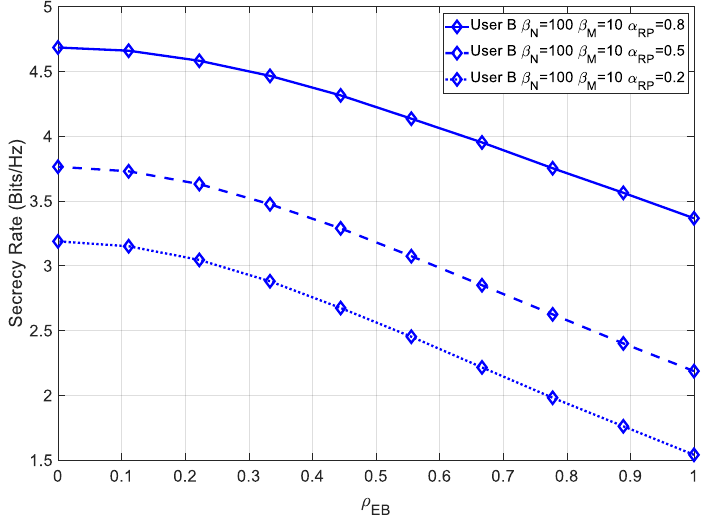
Figure 10. Secrecy rate of the 8 × 8 receiver B with channel estimation errors on both the receiver and eavesdropper, as well as a permanent channel mismatch error, for various ray power coefficients.